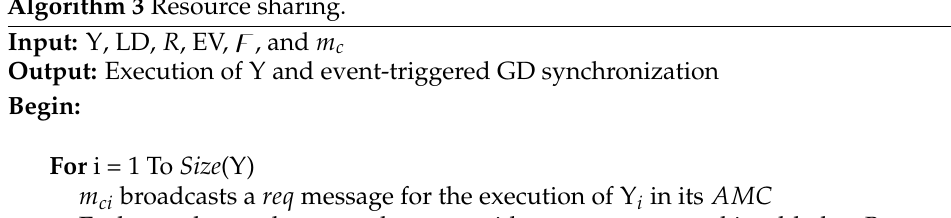
Figure 5. Migration of nodes among AMC s. Algorithm 3 Resource